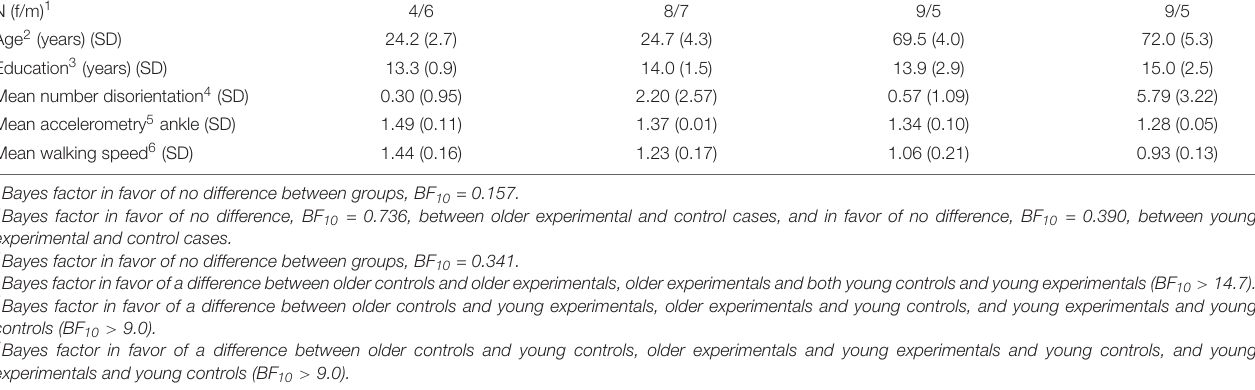
TABLE 1 | Demographic, orientation, and gait characteristics. Young controls Young experimental Older controls Older experimental